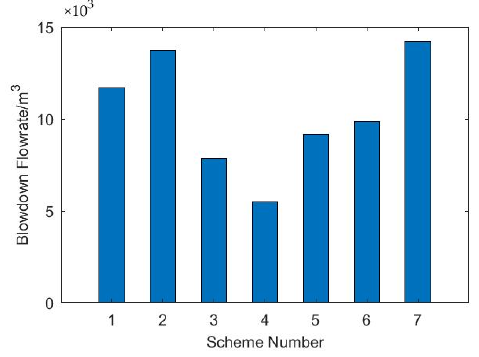
Figure 12. Comparison of blowdown flowrate.